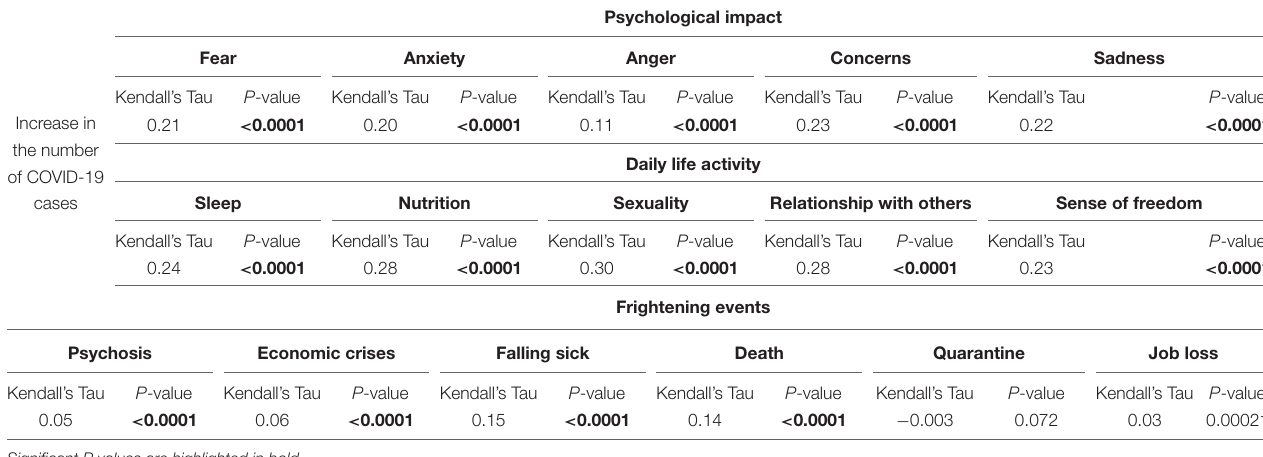
TABLE 6 | Correlations values (Kendall’s tau statistics) relating to “psychological impact and daily life activity” categories. Daily life activity Psychological impact Anger Concerns Sadness